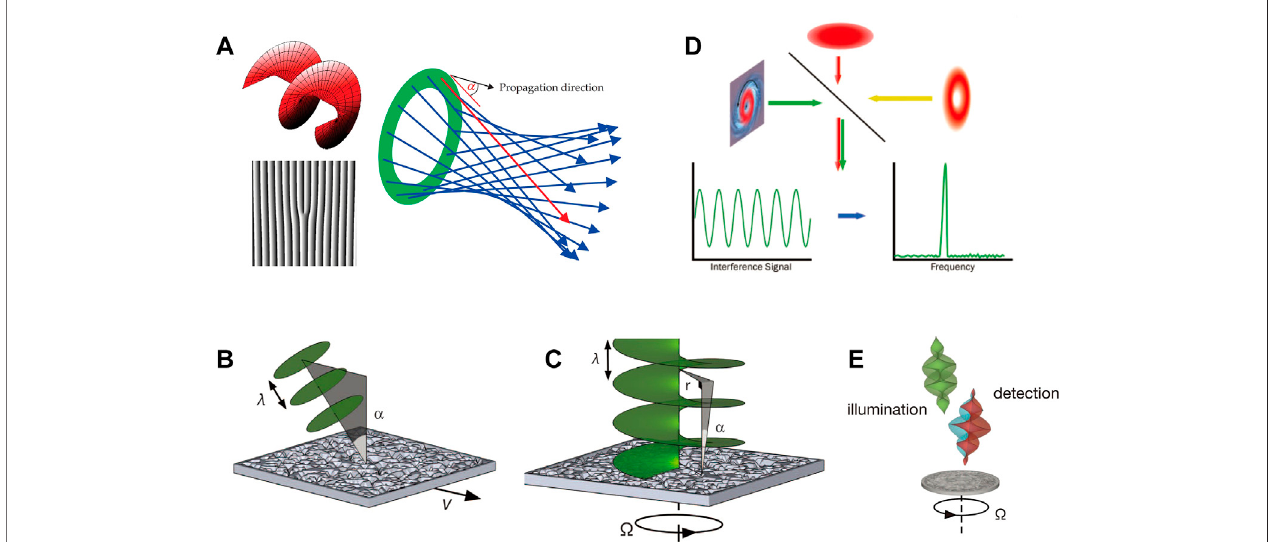
FIGURE 1 | The wave properties of optical vortex and the measurement ofRDE frequency [30] (A) The Poynting vector of the vortex light (B) Translational Doppler frequency shift and (C) rotational Doppler frequency shift [31] (D) The detection scheme of the rotational Doppler shift with structured light [36] (E) A superposition of helically phased beams with opposite signs of ℓ incident on a surface rotating at a speed Ω , results in a Doppler shift of the coaxial light.